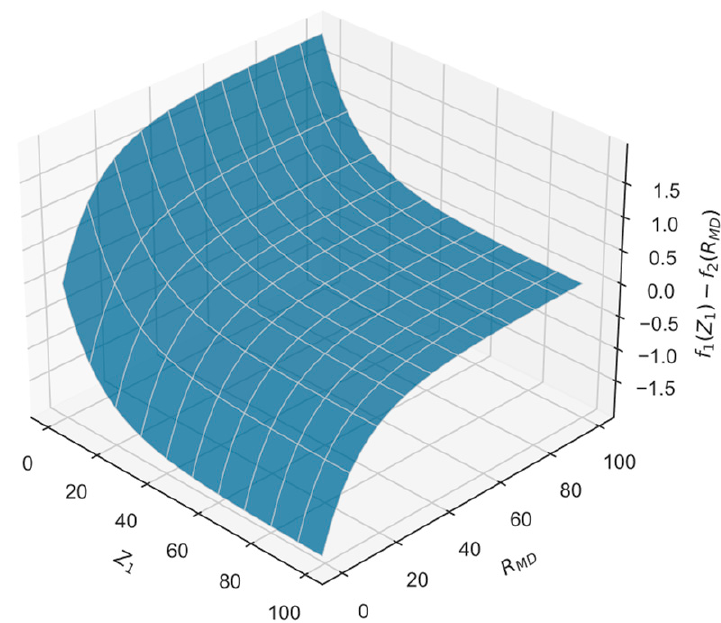
Figure 4. Reward shaping for missile